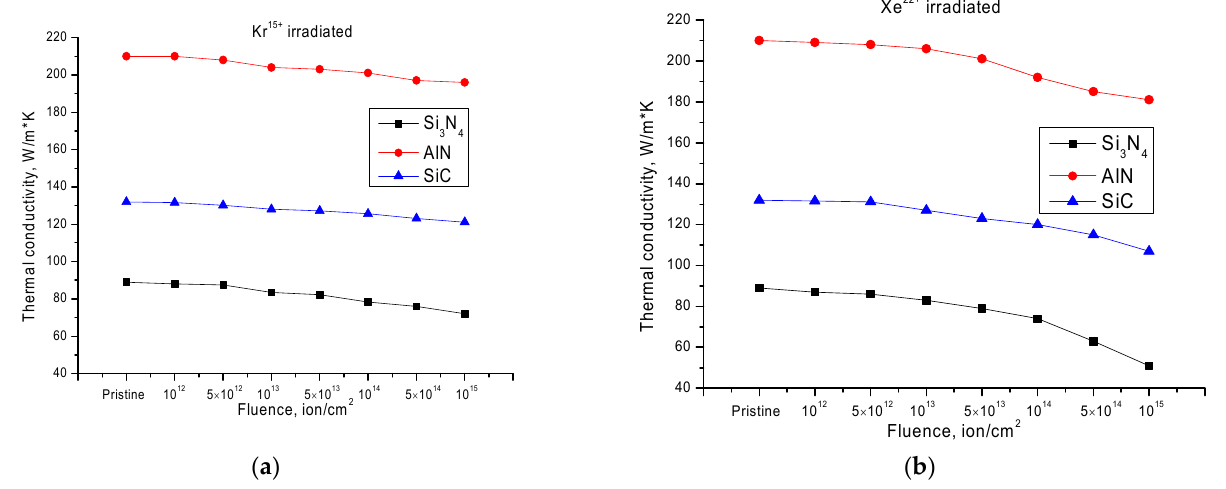
Figure 3. The results of changes in the thermal conductivity coefficient of the investigated ceramics depending on the type of incident ions: ( a ) irradiation with Kr 15+ ions; ( b ) irradiation with Xe 22+ ions.